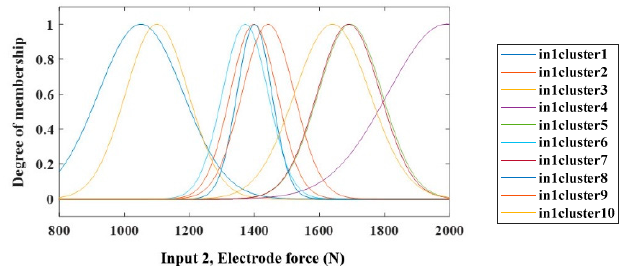
Figure 6. Optimized membership functions for the electrode force.